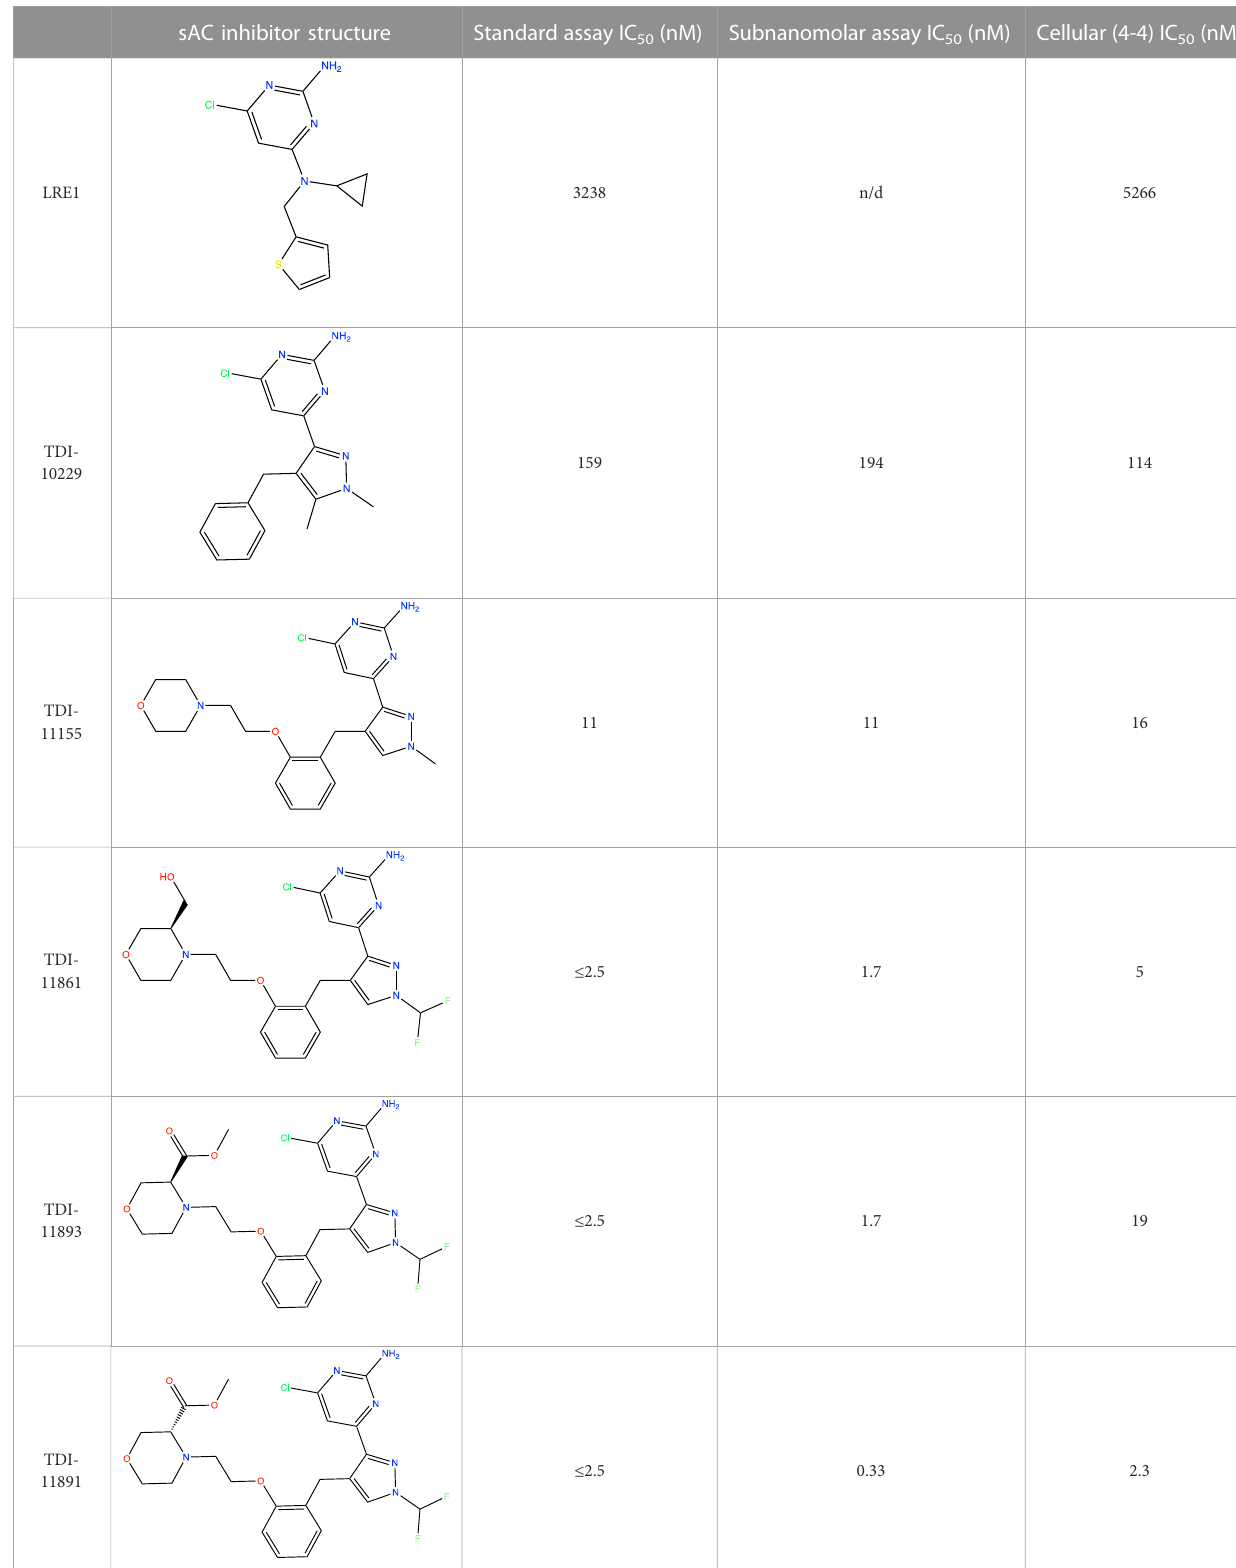
TABLE 1 In Vitro Biochemical and Cellular Potency of sAC